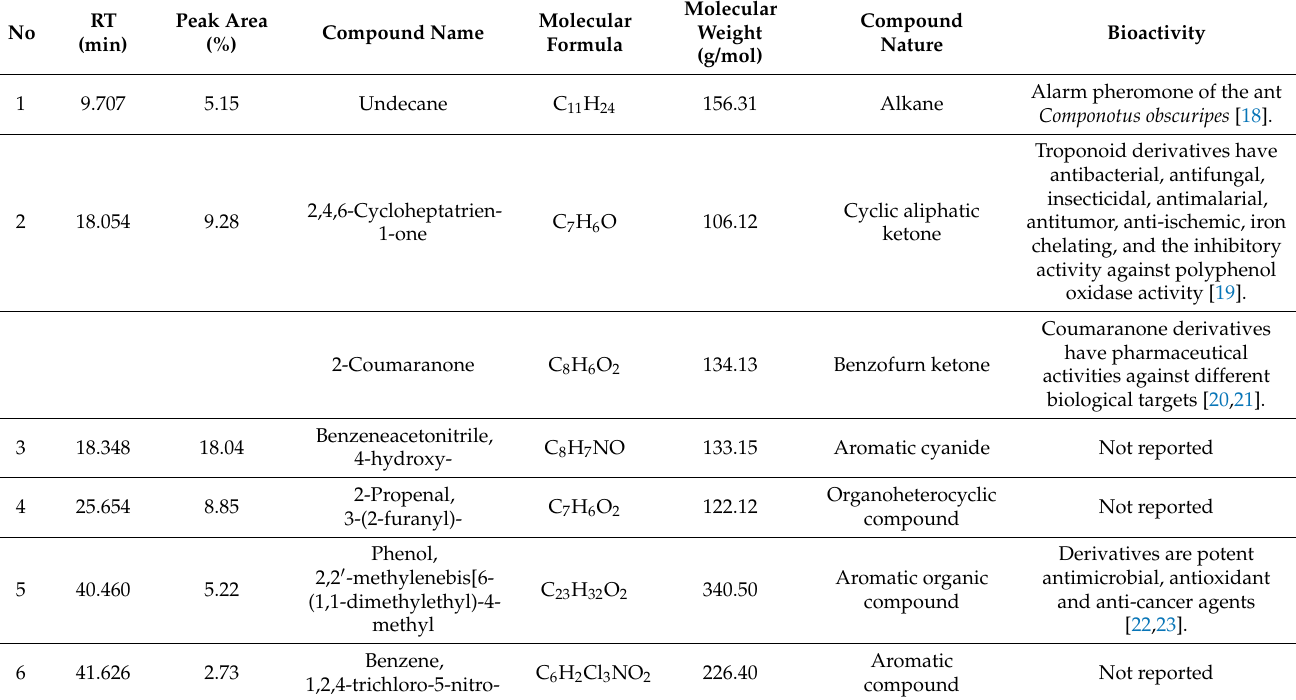
Table 1. GC-MS composition of Ziziphus spins-christi methanol root